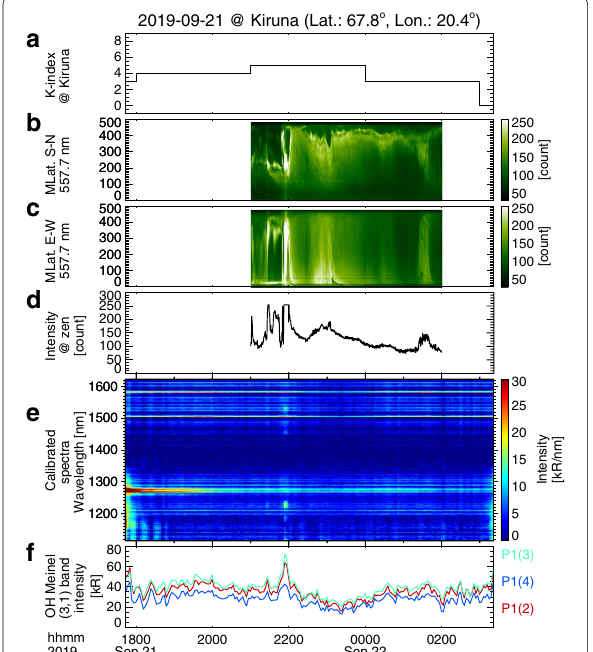
Fig. 6 NIRAS measurements with the 150-lpmm grating at IRF, Kiruna on September 21, 2019. a Local K -index obtained from geomagnetic field observations at Kiruna. b and c are keograms along geomagnetic north–south and east–west directions, respectively. d Auroral intensity at a geographic zenith as a function of time e Dynamic spectrum from 1114 to 1624 nm obtained by the NIRAS. f P 1 (2), P 1 (3), and P 1 (4) line intensities in OH (3,1) band as a function of